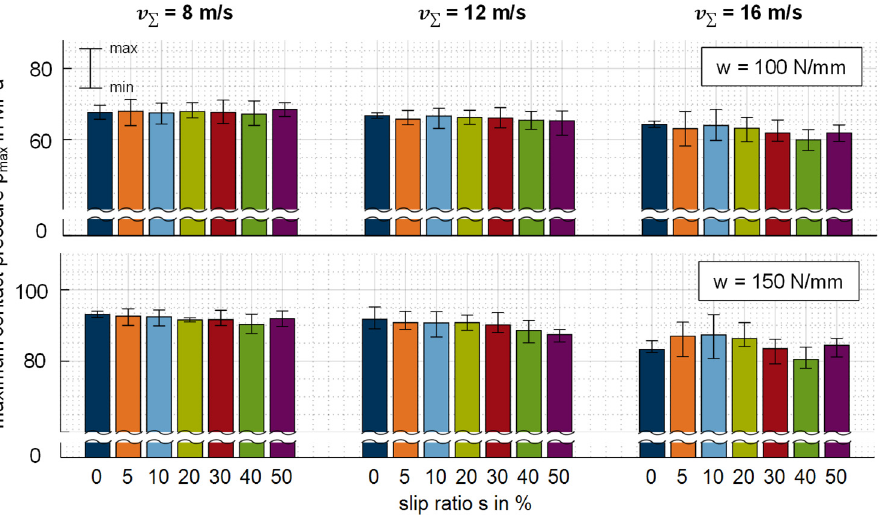
Figure 13. Evaluated maximum contact pressure p max for the thermoplastic EHL contact ZrO 2 /PEEK in comparison with various line loads w, sum velocities v Σ and slip ratios